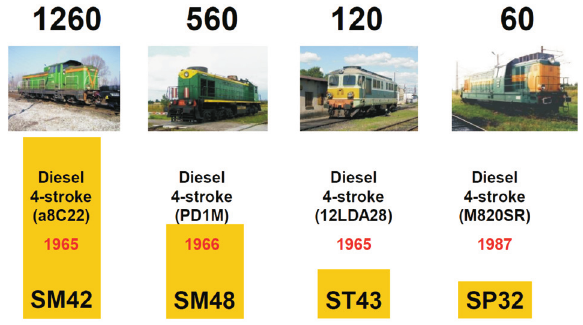
Fig. 13. Diesel locomotives in Poland Table 1. Shunting locomotives operated in Poland [24]